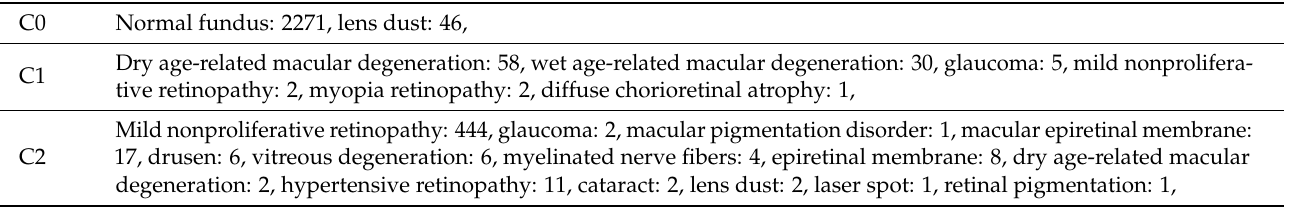
Table A1. Keywords from ODIR dataset which appear in train